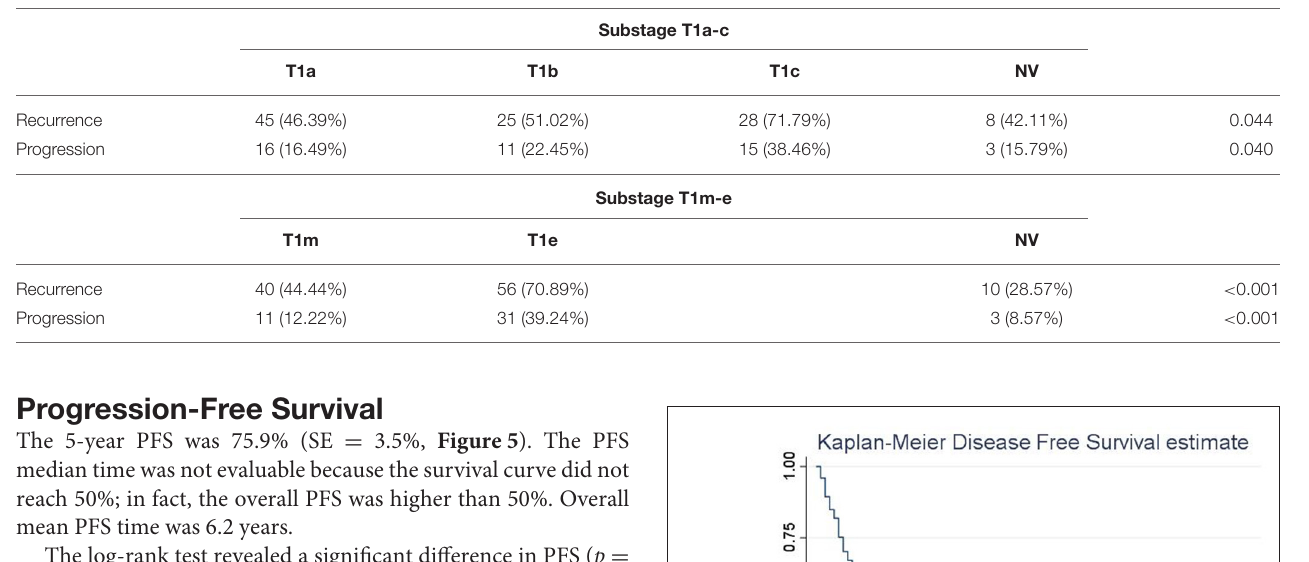
TABLE 5 | Recurrence and progression by subcategory.